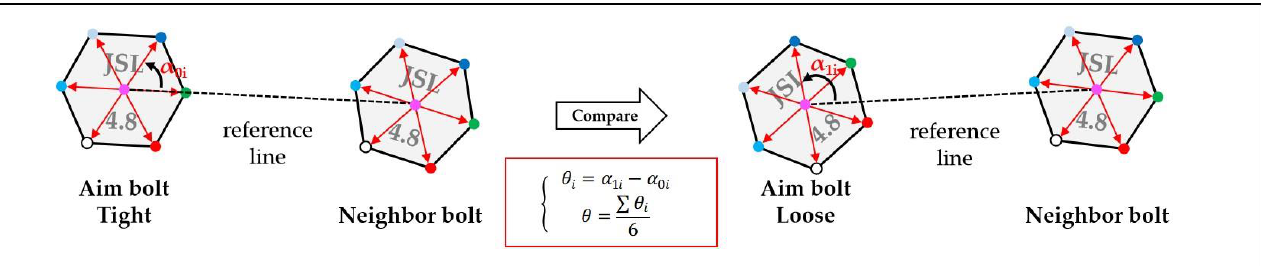
Figure 13. The angular state of the fist bolt corner to the reference line.